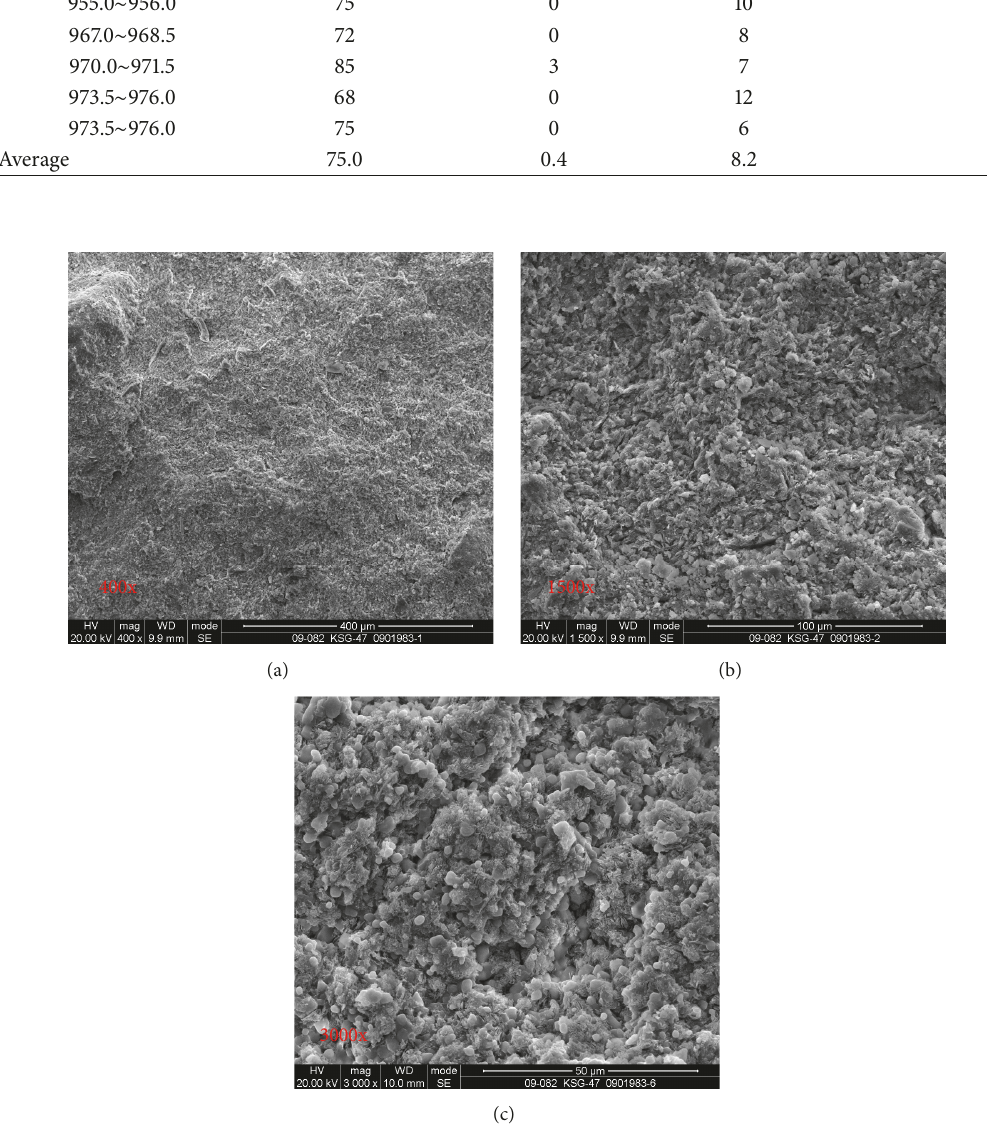
Figure 4: SEM images of a mudstone interlayer at different